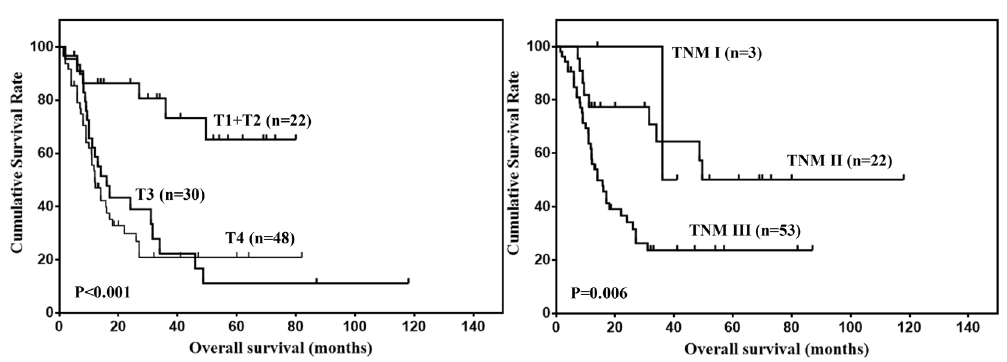
Figure 1. OS of gastric ASC stratified by tumor depth and TNM